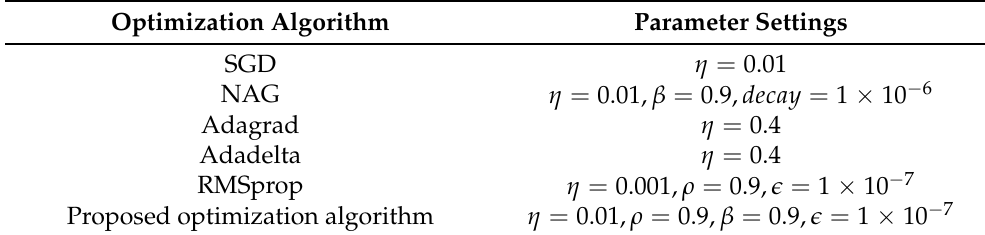
Table 3. Different optimization algorithms and their parameter